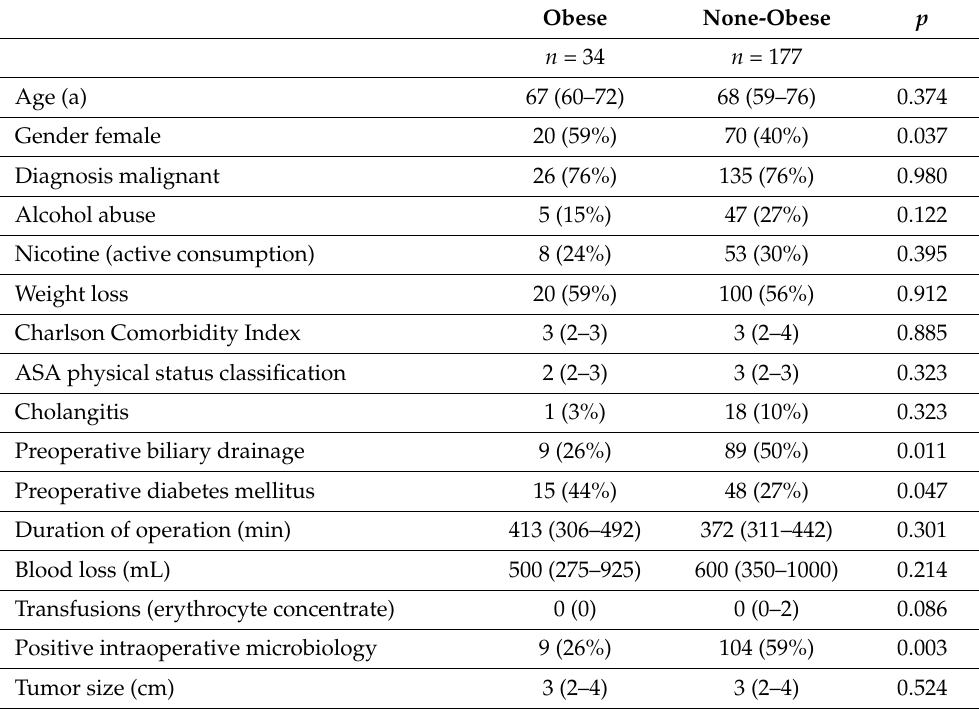
Table 1. Demographic and perioperative